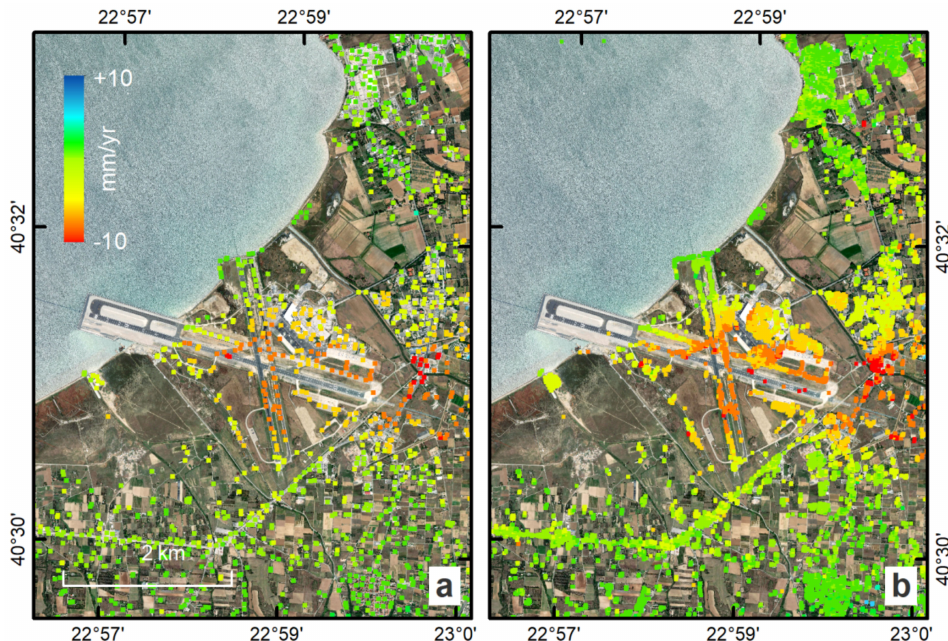
Figure 11. Sentinel-1 PSI average LoS displacement rates for the period 2015–2020 over Thessaloniki International Airport using the SNAPPING PSI ( a ) Med and ( b ) Full resolution services. The improved density of measurements using PSI Full service is shown. Contains modified Copernicus Sentinel-1 mission data (2015–2020), processed by AUTh on